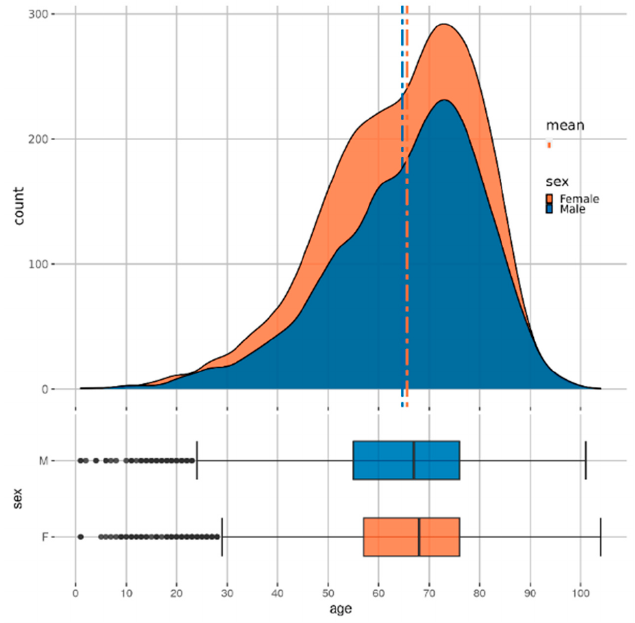
Figure 2. Distribution of age and sex in the CKD cohort.